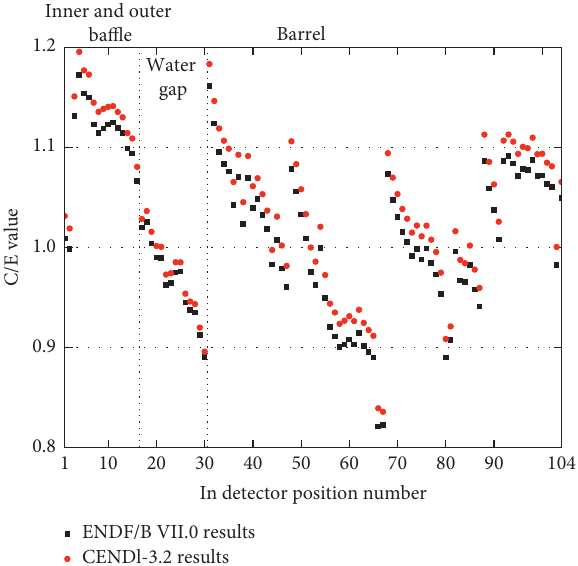
Figure 6: Equivalent fission flux ratios (calculated/experimental) of the 115 In(n,n’) 115m In detector.